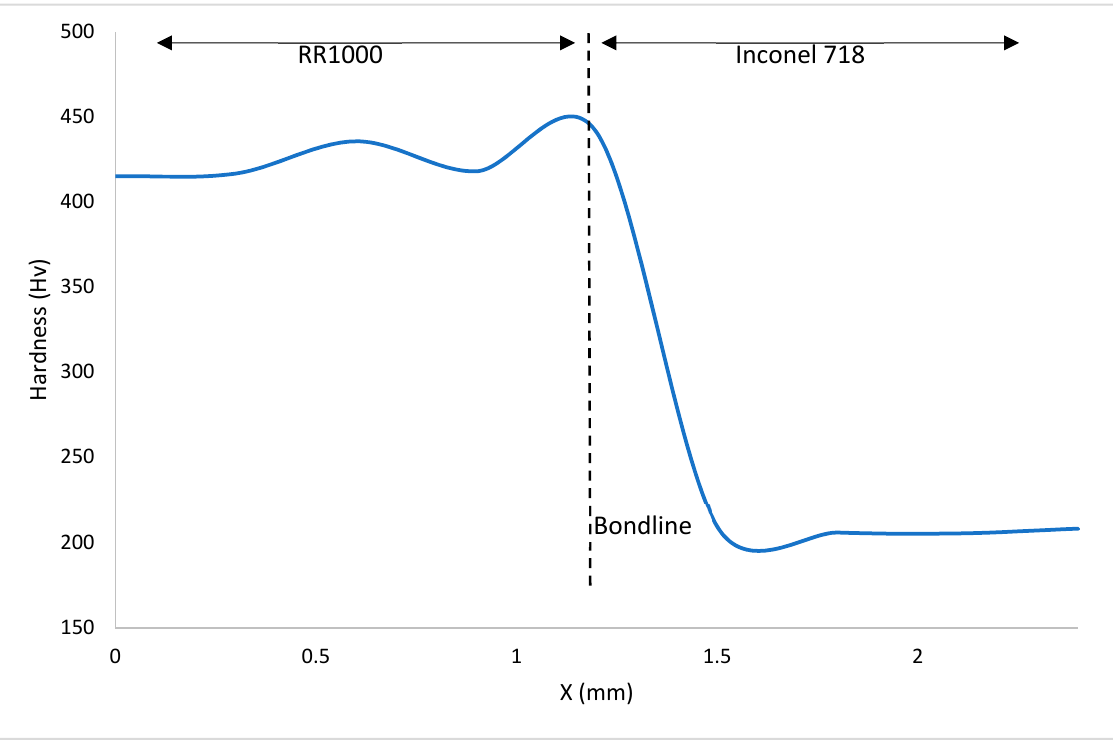
Figure 10. Graph detailing Vickers Hardness variation in bond 2.